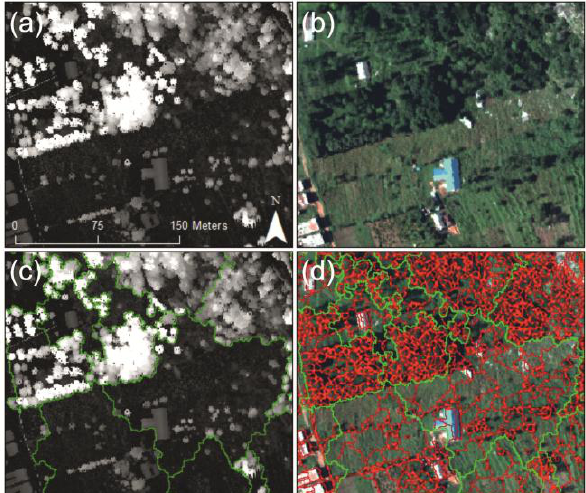
Figure 2. Examples of canopy height model (a), AISA data (b), level-0 segmentation (c) and level-1 segmentation inside level-0 segments (d).